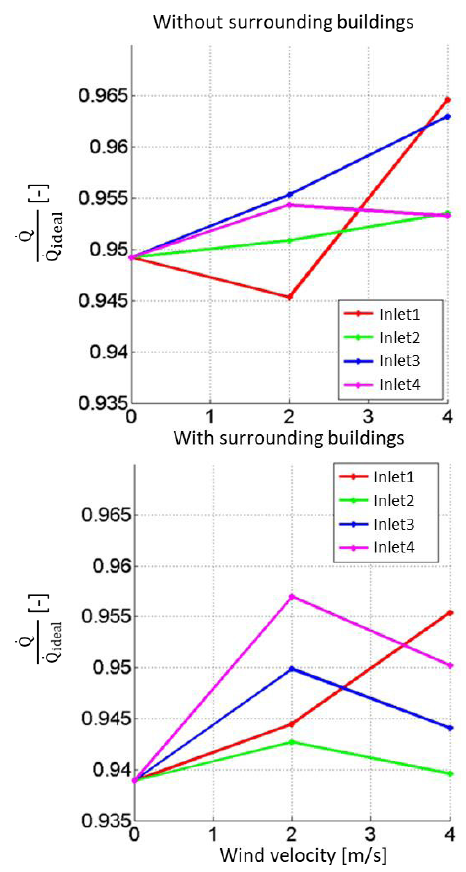
Fig. 11. Heat duty for uniform and real velocity